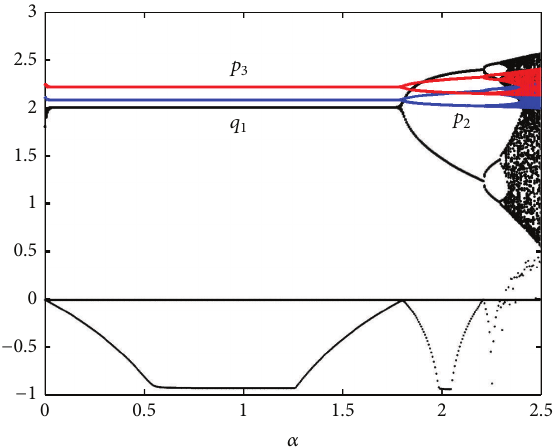
Figure 10: The bifurcation diagram of the controlled system (21) for 𝑘 = 0.8 , 𝛽 = 0.15 , 𝛾 = 0.2 , and 𝛼 varying from 0 to 2.5.